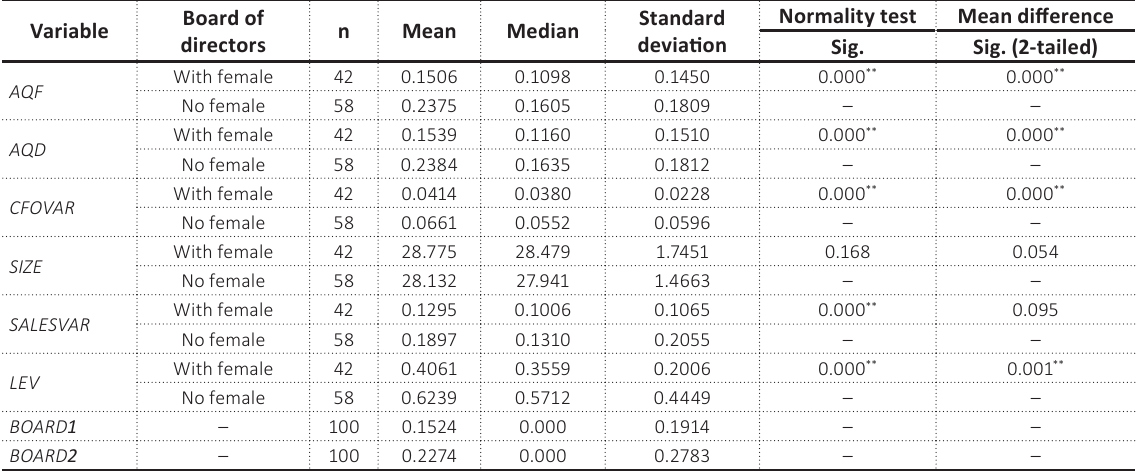
Source: IDX, processed.